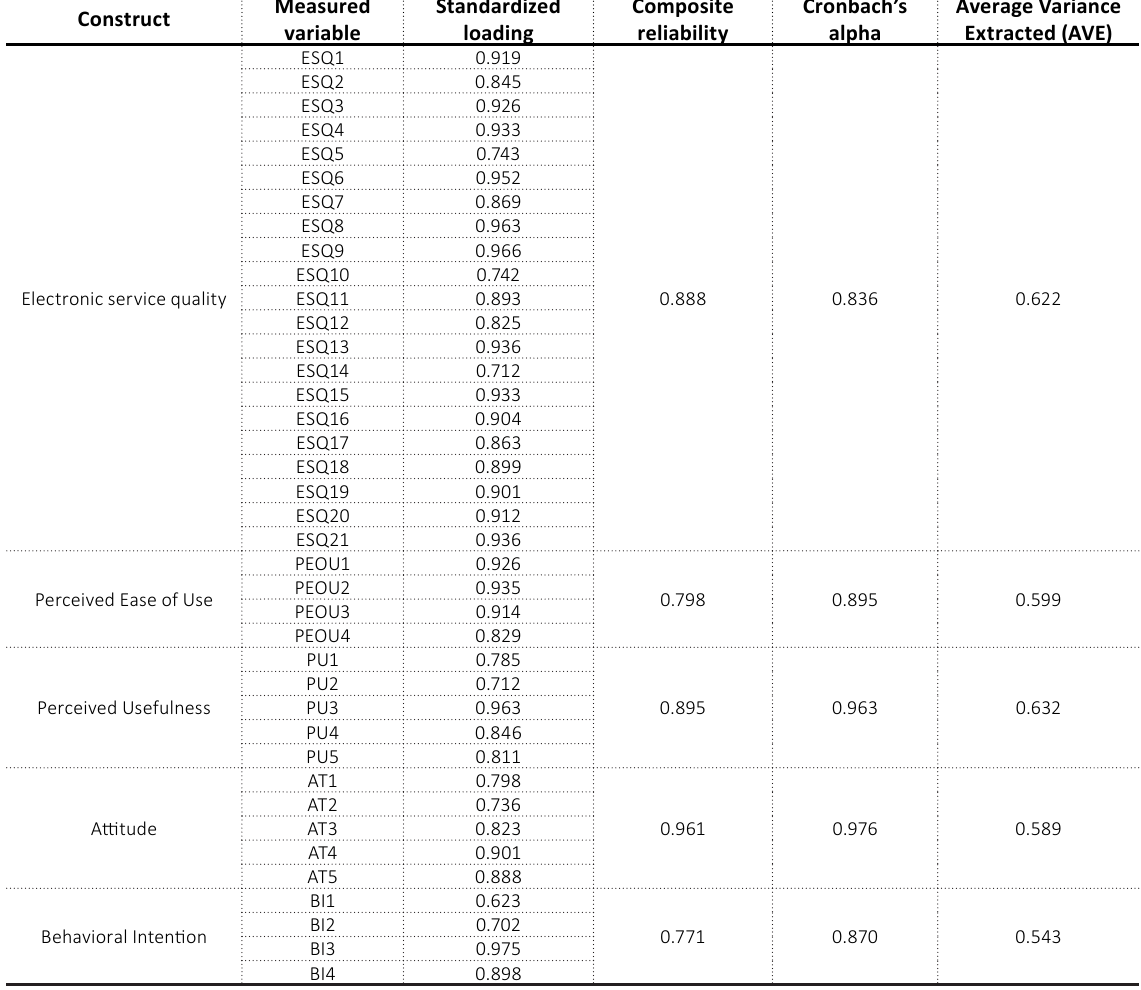
Table 2. Confirmatory factor analysis